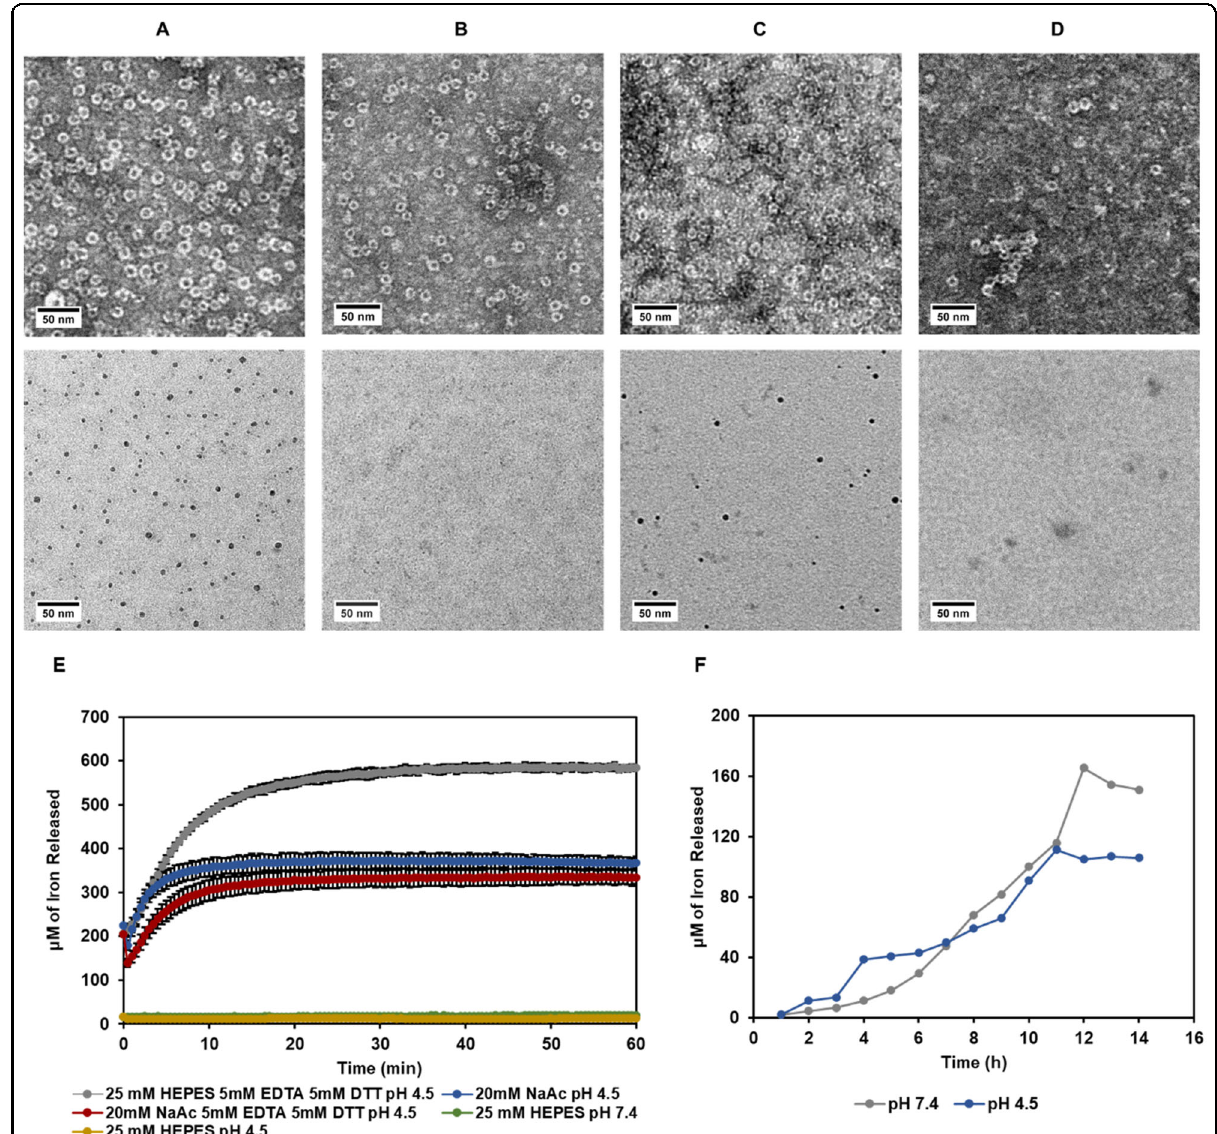
Fig. 4 Structural analyses and iron release of AfFtnAA in lysosomal degradation condition in vitro. A – D Transmission electron micrographs (top row — stained, bottom row — unstained) demonstrating lysosomal degradation. AfFtnAA in the presence of ( A ) 25 mM HEPES, pH 7.4; ( B ) 20 mM NaAc, 5 mM DTT, 5 mM EDTA, pH 4.5; ( C ) 25 mM HEPES, 1 unit of cathepsin-B, pH 4.5; and ( D ) 25 mM HEPES, 1 unit of cathepsin-B, pH 7.4. E Cumulative iron release after incubation with AfFtnAA under different reducing/nonreducing conditions for 1 h ( n = 3, where n is the number of repeats conducted for each experimental condition). F Cumulative iron release after incubation with AfFtnAA in the presence of the lysosomal enzyme cathepsin-B at pH 7.4 and pH 4.5 for 14